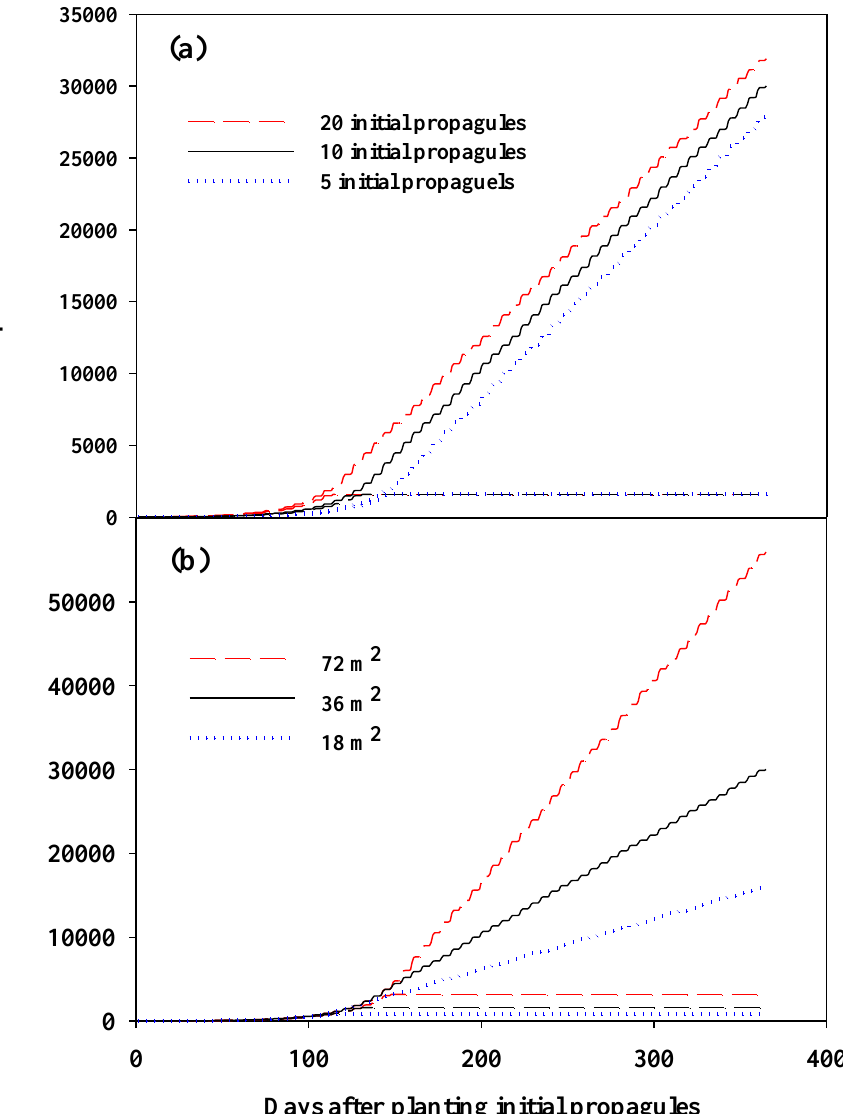
Figure 6. Time courses of cumulated numbers of runner plants simulated by a program to predict number of transplants for autotrophic transplant production method as affected by number of initial propagules ( a ) and propagation area ( b ). The solid lines are simulated results by propagation cycles (15, 27 and 43) and ten propagules in 36 m 2 propagation area (maximum capacity number of propagules: 1600) and dash and dotted lines are results simulated by increasing and reducing propagation area or number of initial propagules by two times the result of solid line.